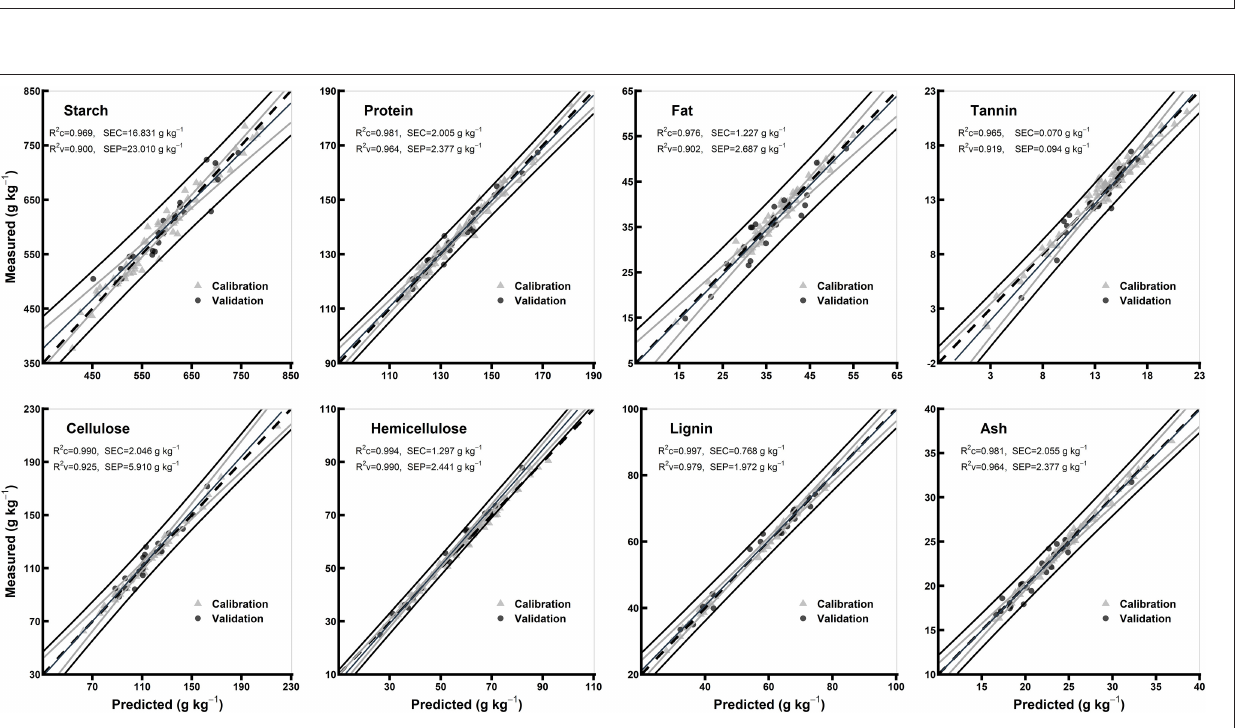
FIGURE 4 | Comparison of scatter plots of measured vs. predicted values (g kg − 1 ) of the whole grains for starch, protein, fat, tannin, cellulose, hemicellulose, lignin, and ash of sorghum grains for the external validation subsets based on PLSR models. The black and gray lines in plot showed mean, maximum, and minimum values while dotted lines showed average chemical composition between calibration and validation sample set.